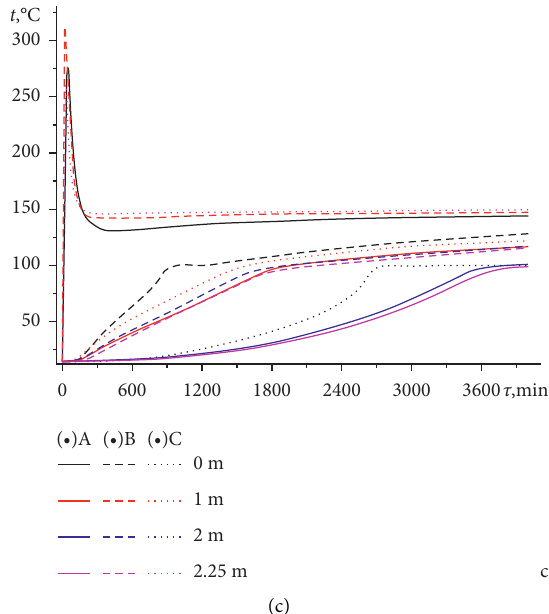
Figure 13: Time dependences of temperature changes at various points lying on the axis of a graphite and aluminum under various boundary conditions. (a) A heat insulator is located at the boundary of the region (adiabatic conditions). (b) There is air at the border of the region. (c) There is concrete on the border of the